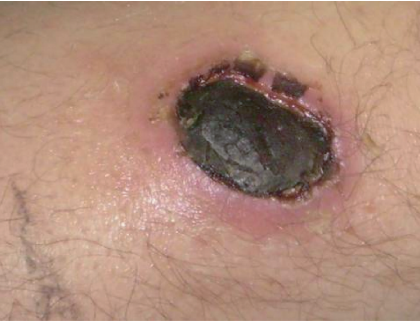
Figure 3: Close-up view of the eschar on the left pretibial area.